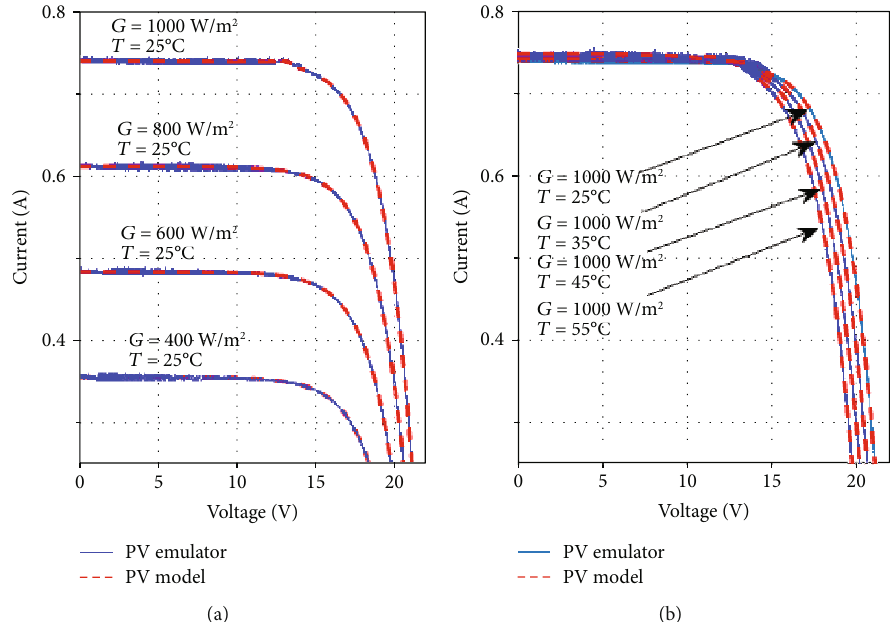
Figure 13: (a) Generated I-V characteristics for a fi xed temperature and variable solar radiation, (b) generated I-V characteristics for a variable temperature and fi xed solar radiation.